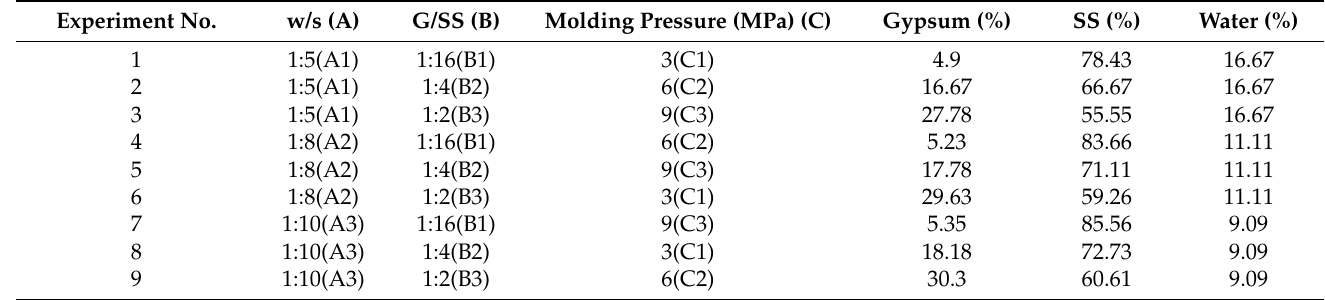
Table 2. Orthogonal experiment proportions.